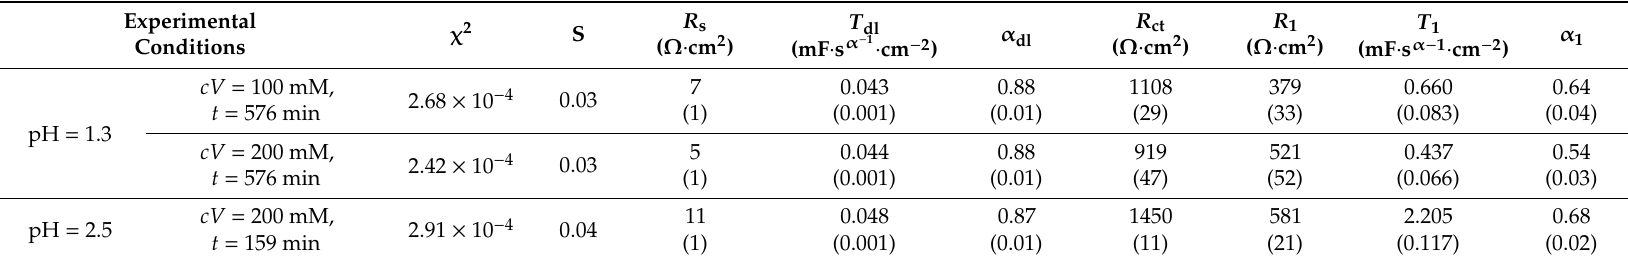
Table 4. The results of fitting of the impedance spectra obtained when corrosion was inhibited, using EEC from Figure 11b: χ 2 and S indicate the quality of the fit (chi-square and residual sum of squares, respectively); R s is the solution resistance; T dl is the parameter of the constant phase element CPE dl representing the electrical double layer; α dl is the exponent of the CPE; R ct is the charge-transfer resistance; R 1 , T 1 and α 1 are the resistance and constant phase element CPE 1 parameters related to the adsorption / formation of a protective layer processes, respectively, uncertainties of the fitted parameters are given in